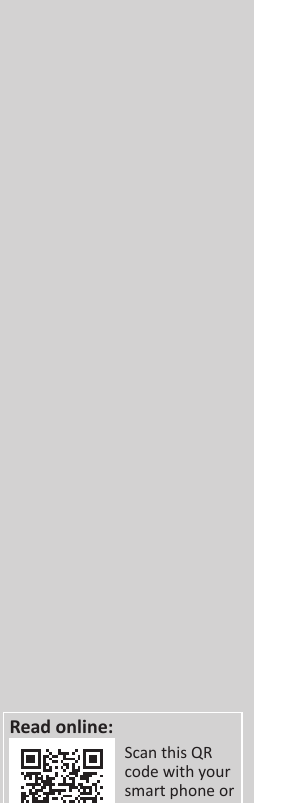
FIGURE 2: Sagittal (a) and (b) axial images of the abdomen in venous phase after intravenous contrast